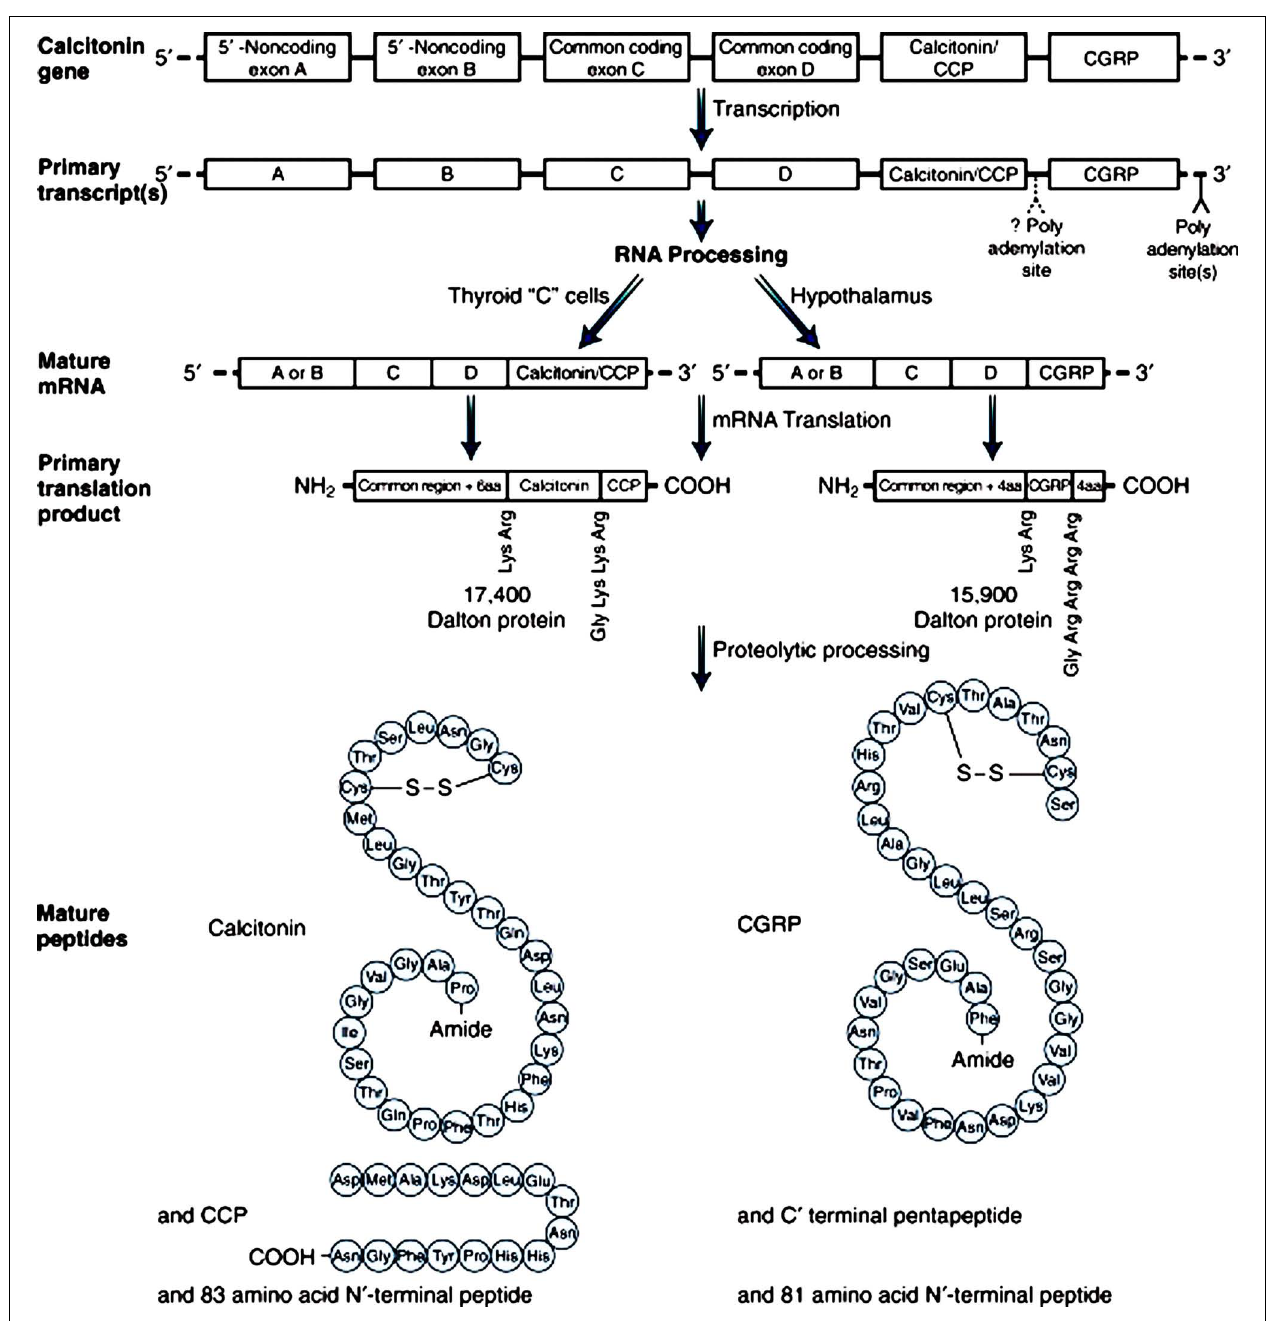
FIGURE 1 |Tissue-specific expression of the calcitonin gene by alternative splicing. Splicing of alternative exons leads to two different mRNAs.The mRNA encoding calcitonin is found predominantly in the thyroid C cell; the mRNA encoding a CGRP is found predominantly in the hypothalamus and other nervous tissue. CGRP, calcitonin gene related peptide; mRNA, messenger RNA; CCP, calcitonin carboxyl-terminal peptide. From Amara etal. (1982), with permission.